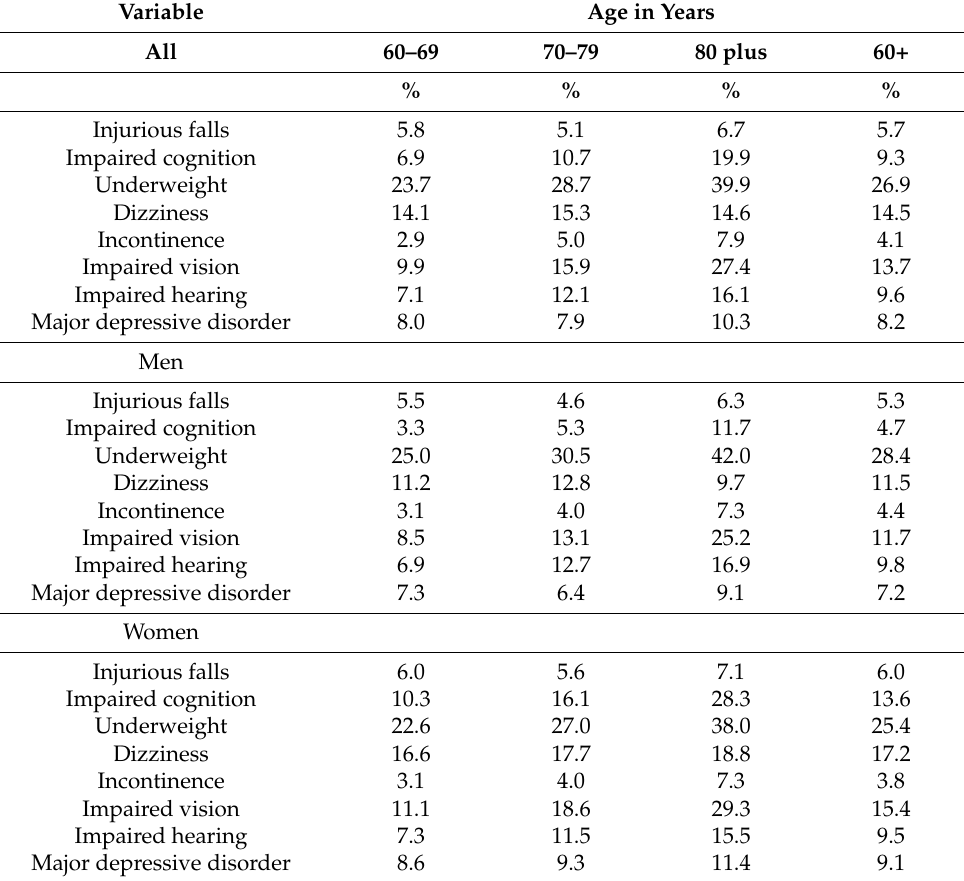
Table 2. Geriatric conditions by age group and